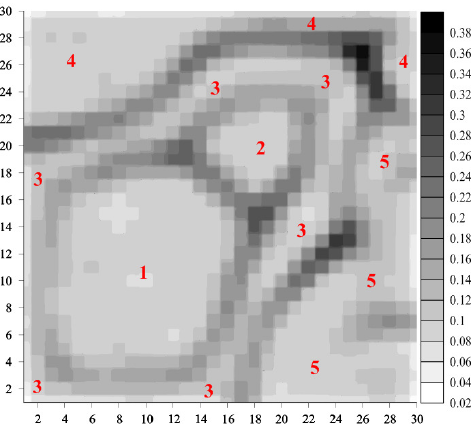
Figure 8. Gray-level U-matrix map for the visualization of the synthetic data set of Figure 6a (U-matrix is calculated for the neuron map of Figure 6i).